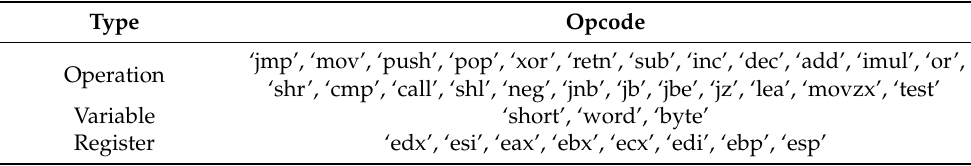
Table 2. Three kinds of primary extracted opcodes.